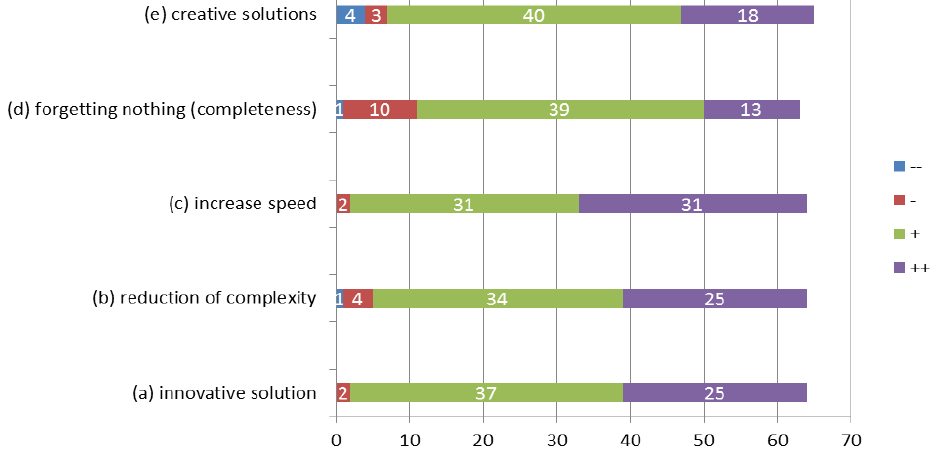
Figure 7. Expected benefit of using recommender